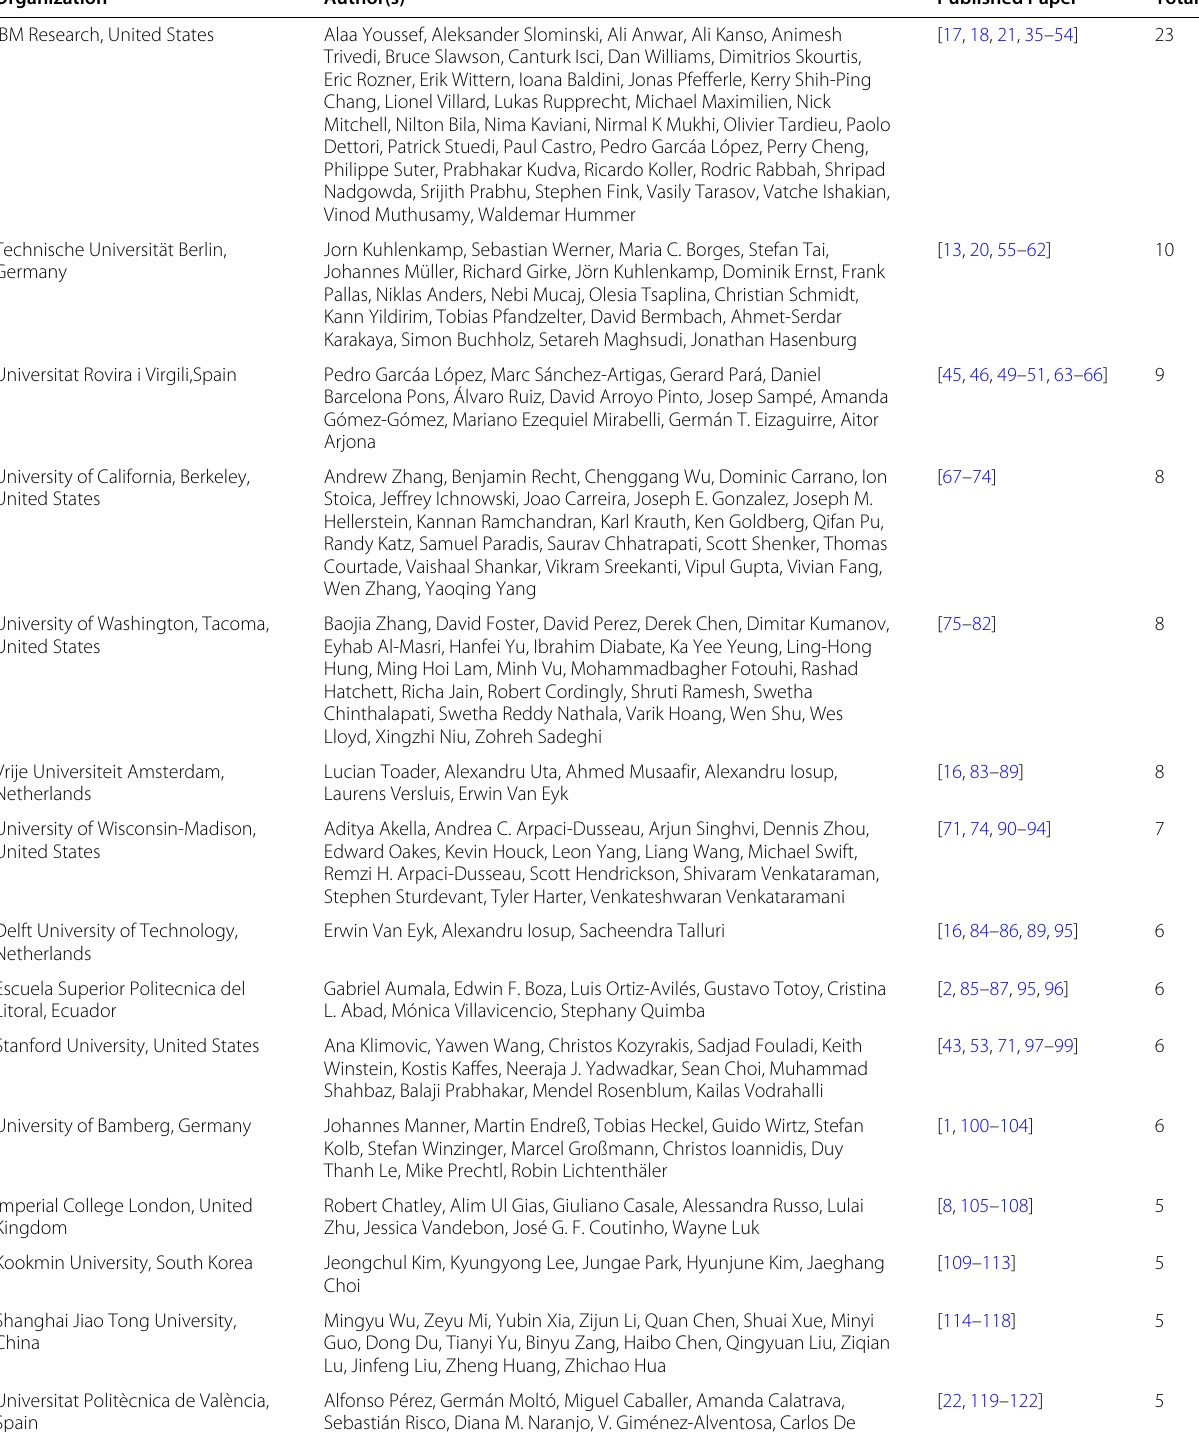
Table 4 Organizations, and researchers active in researching serverless computing